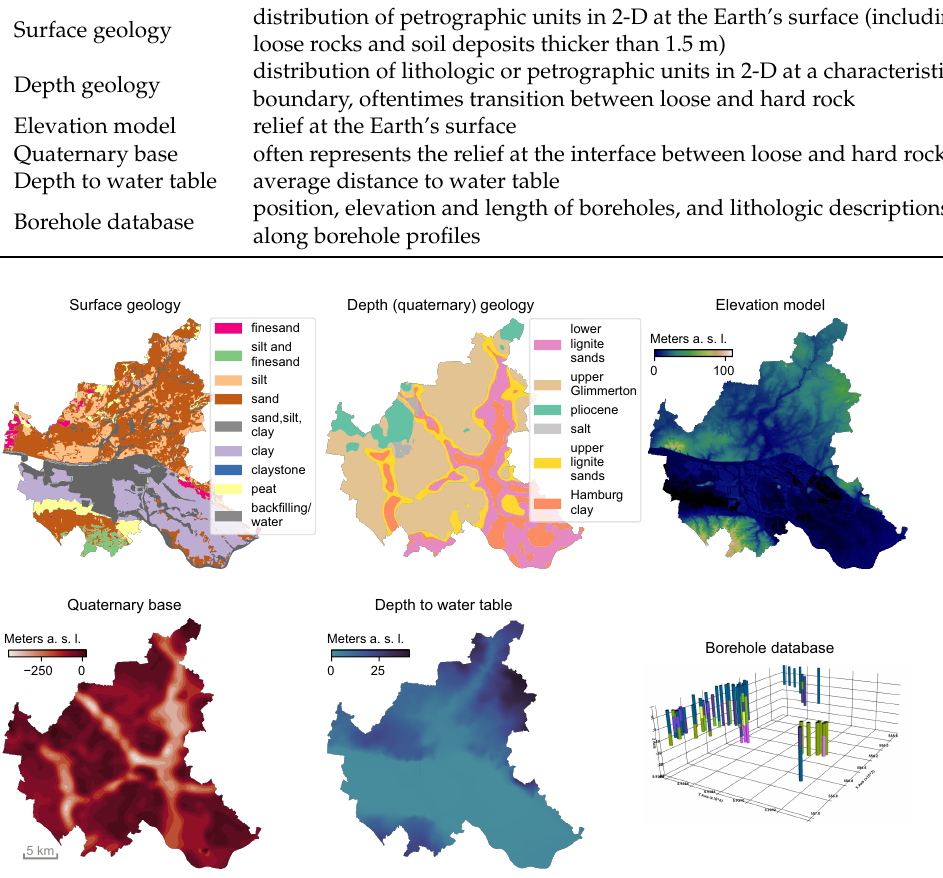
Figure 1. Visualization of the six input data types (Table 1) for the federal state of Hamburg. Borehole data is shown for a small sub-region